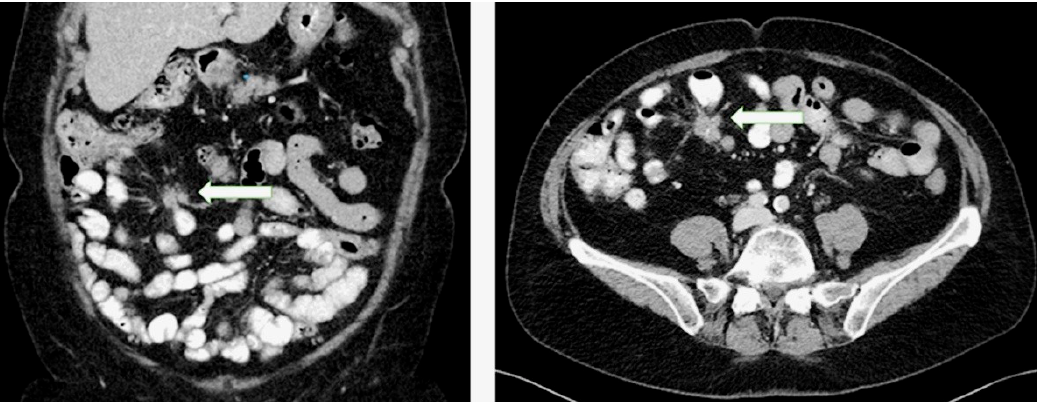
Figure 3. Presence of mesenteric fibrosis in a patient with a small intestinal neuroendocrine tumor as an enhancing soft-tissue mass with fibrotic bands radiating outward in the mesenteric fat in a stellate pattern around a lymph node metastasis in coronary and transverse planes.